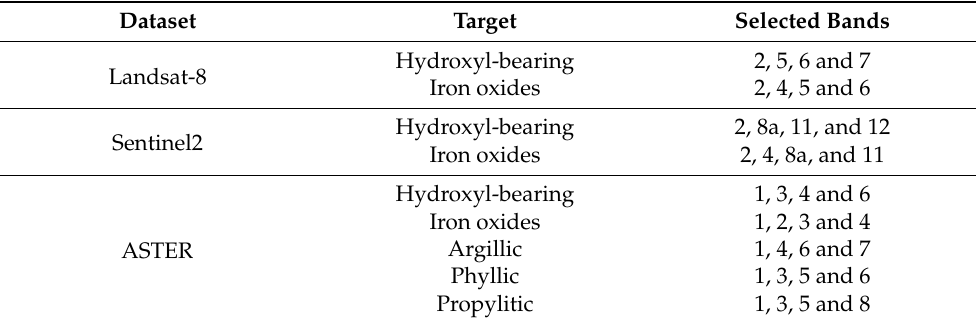
Table 3. Selected bands of each sensor’s data to perform PCA transformation for mapping defined targets. Dataset